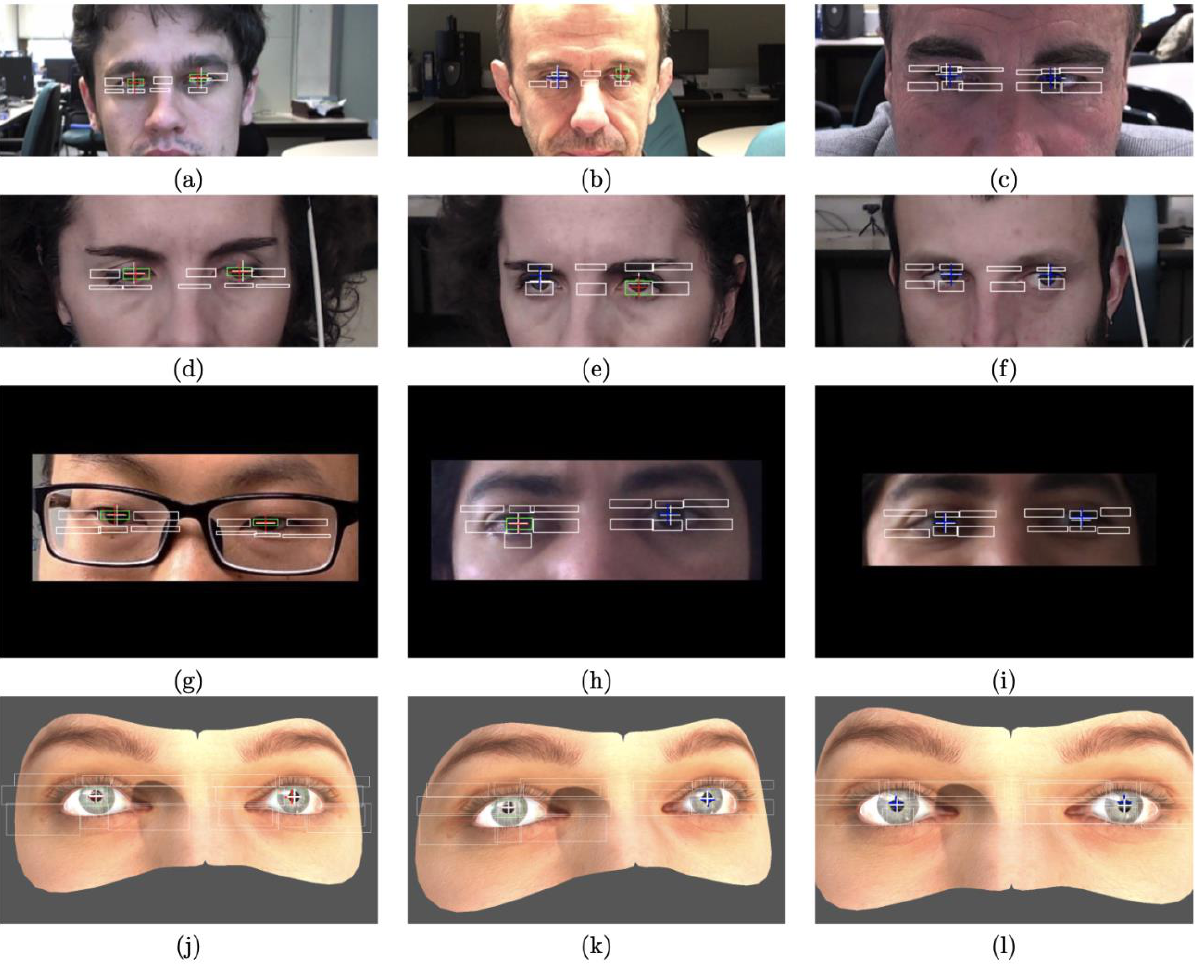
Figure 6. Randomly selected samples output images from the proposed approach on a dataset basis from top to bottom: GI4E, I2Head, MPIIGaze and U2Eyes. Each column demonstrates the cases where pupils are estimated from both detected pupils, from one detected pupil and from the result of the post-processing algorithm, and both from the post-processing algorithm, respectively. All the white bounding boxes are the members of BB. All the green boxes are the members of P . The white and the green plus signs are the ground truths and the estimated pupil center locations,